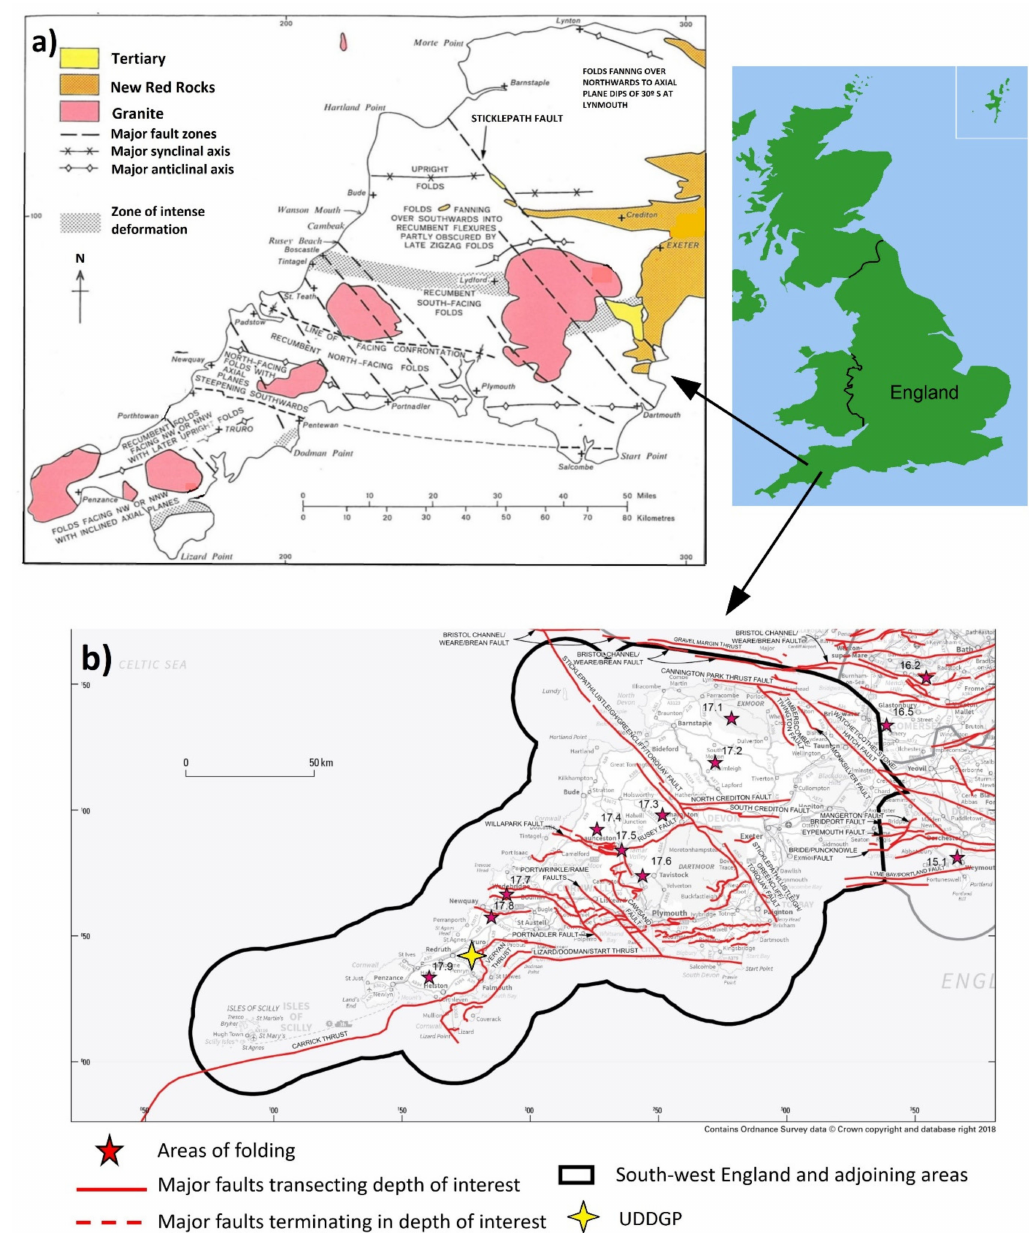
Figure 6. ( a ) Major faulting across the SW of England and granite location [50]. ( b ) Major faults and areas of folding in the South West England region, and location of the UDDGP project, Contains Ordnance Data © Crown Copyright and database rights 2018. Ordnance Survey License no. 100021290. Contains British Geological Survey digital data © UKRI 2018